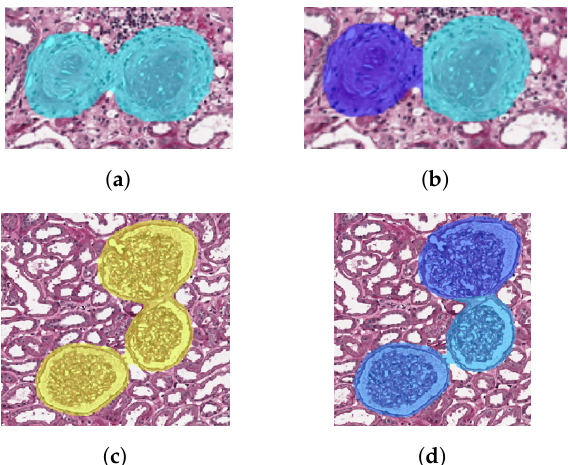
Figure 6. Examples of K-means clustering for both sclerotic and non-sclerotic glomeruli. The number K of clusters is determined according to deltaArea defined in (1). ( a ) Sclerotic glomeruli before clustering. ( b ) Sclerotic glomeruli after clustering, with K = 2. ( c ) Non-sclerotic glomeruli before clustering. ( d ) Non-sclerotic glomeruli after clustering, with K =